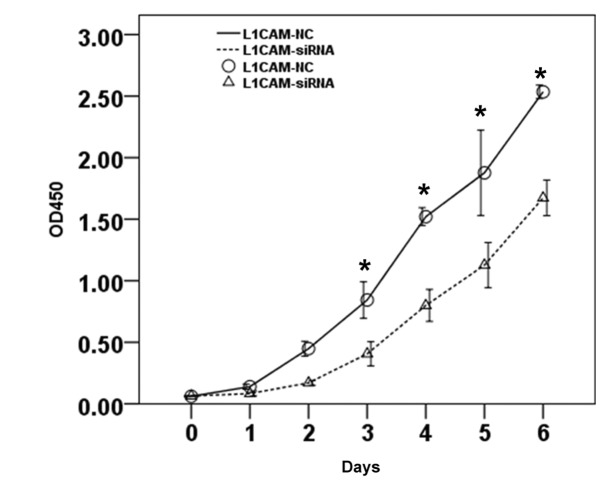
Effect of L1CAM silencing on Capan-2 cell proliferation. Cell viability was measured by cell counting kit-8 assays each day for six days (0–144 h). The results showed that LICAM silencing inhibited cell proliferation in the Capan-2 cells. Viability was expressed at an absorbance of 450 nm. L1CAM, L1 cell adhesion molecule; siRNA, small interfering RNA; OD, optical density.